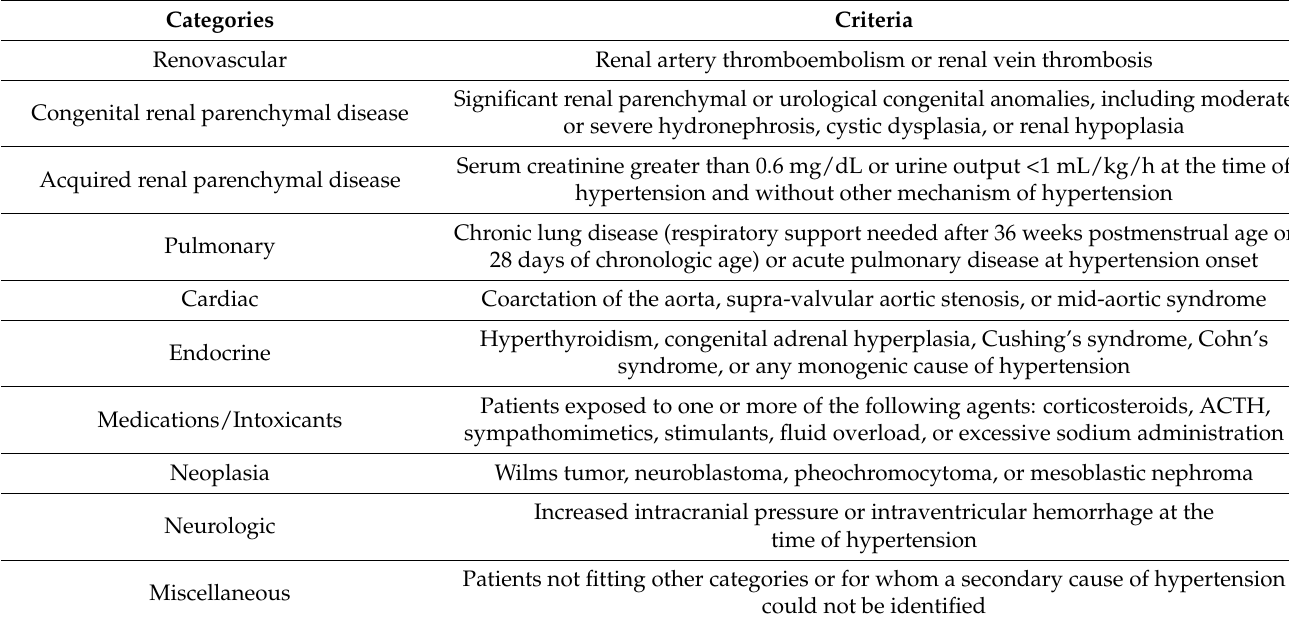
Table 1. Categories of neonatal hypertension from Flynn et al. with criteria for category placement. Reproduced from [29], 2019,